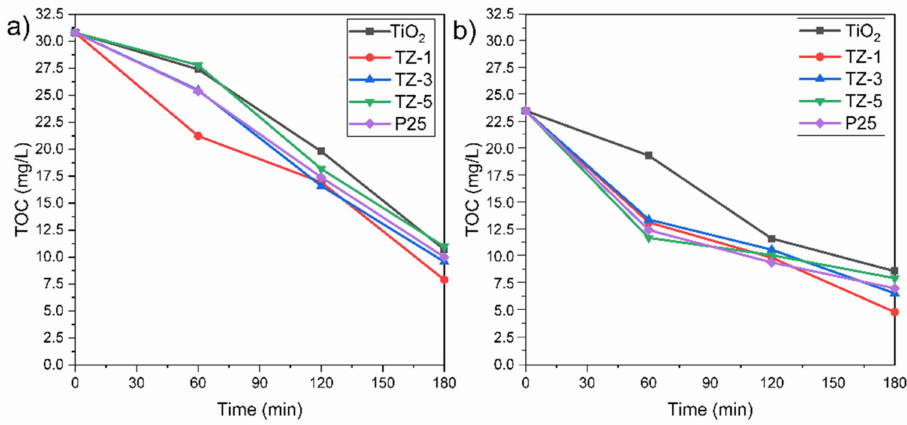
Figure 11. Profiles of TOC removal for ( a ) RhB and ( b ) MO by TiO 2 , TZ-1, TZ-3 and